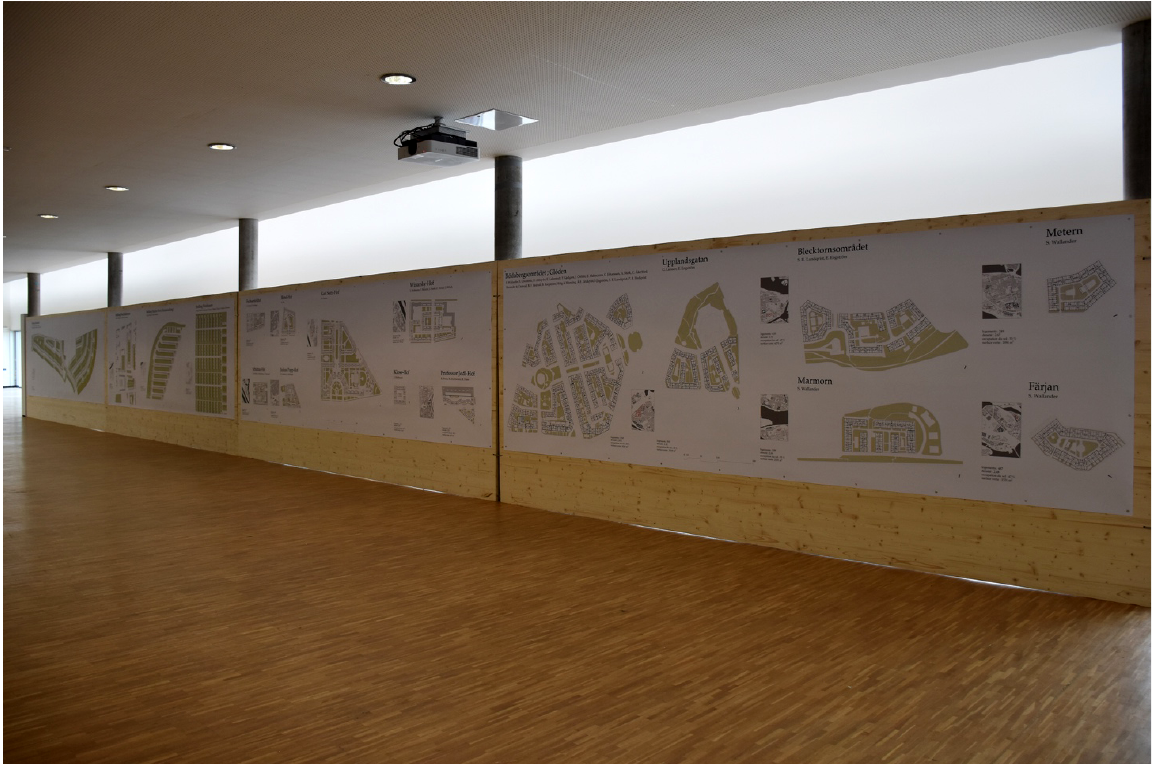
Figure 11. Fourth section: the four panels of typological assemblages. In foreground, there are the Stockholm and Vienna housing examples. Source: